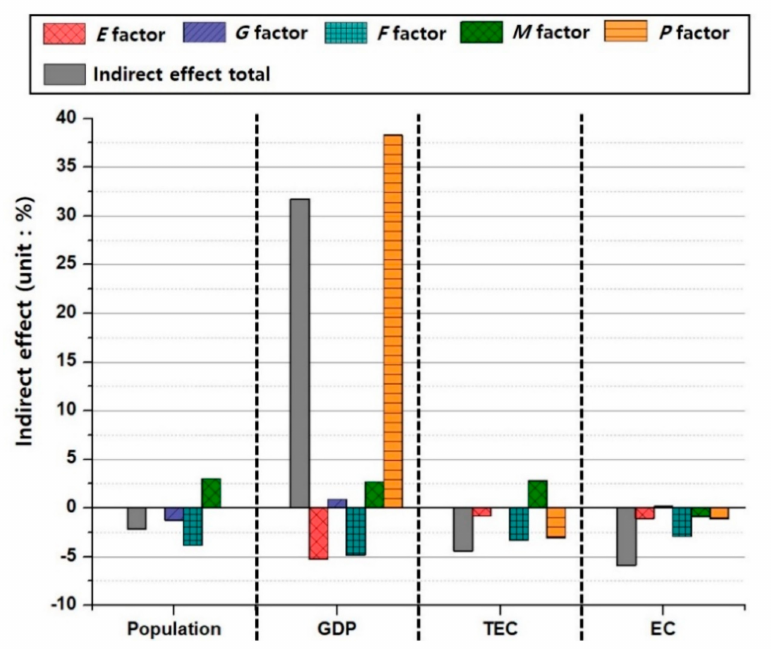
Figure 3. Comparisons of indirect e ff ects of Kaya identity factors in a relationship between decomposed variables and F Foss